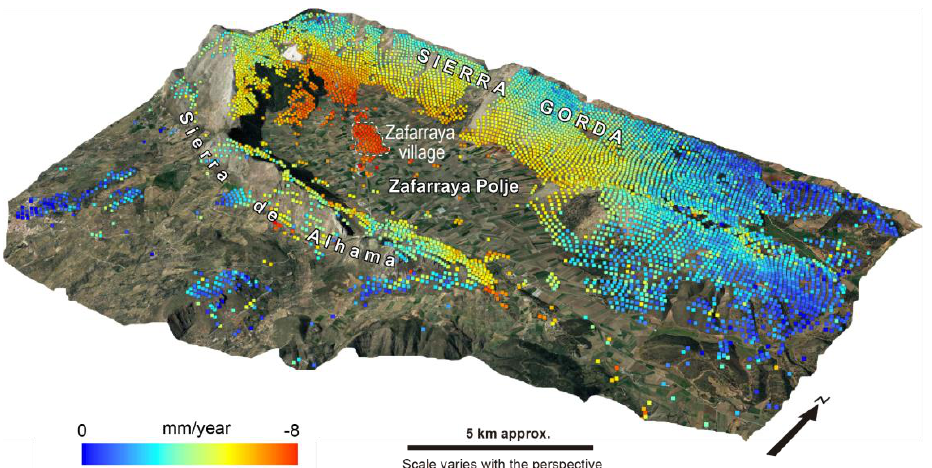
Figure 11. Displacement rate data provided by GEP overlaying a 3D model of the Zafarraya Polje (from Google Earth, www.google.com/earth). Note that the red tones observed in the central sector of the polje are located in the Zafarraya village built on an outcrop of the bedrock.